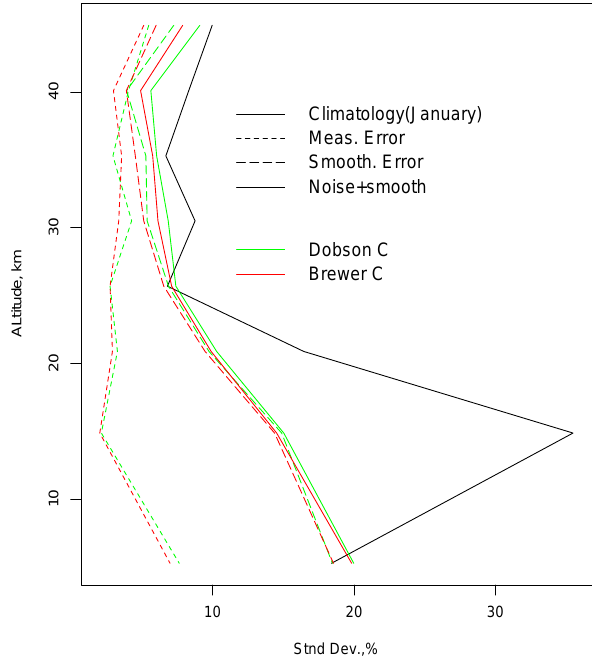
Fig. 7. The errors of ozone retrieval are shown as function of al- titude for Dobson (green solid line) and Brewer (red solid line). Also shown separately are errors associated with the measurement (dotted) and smoothing (dashed) uncertainties that contribute to the ozone profile retrieval error. Climatological ozone variability is shown as black line and is taken from the MLL climatology (McPeters et al., 2007) for Northern middle latitude (40–45 ◦ N) and for the month of January. The covariance matrix used in the smooth- ing error calculations of the Umkehr retrieval is representative of the ozone variability over the middle Northern latitudes based on ob- servations by SAGE II (ozone ∼ above 25km) satellite instrument and ozone sonde (ozone below ∼ 25km) profiles collected between 1988 and 2002.